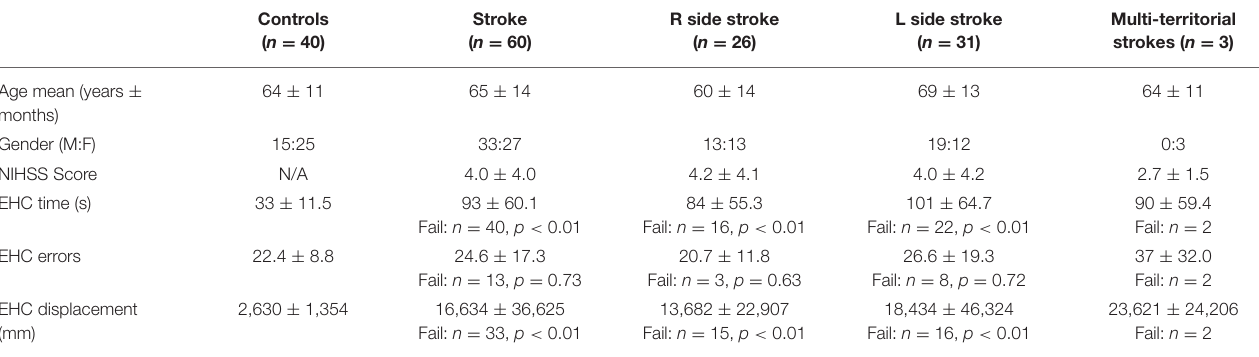
TABLE 1 | Summary of visuomotor and NIHSS score results for controls and AIS groups.